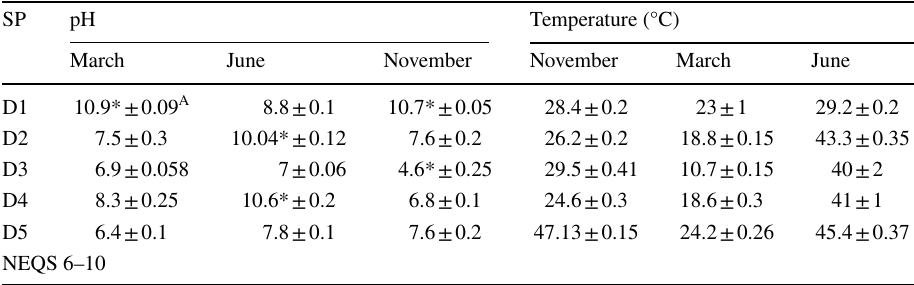
combined drains of HIE